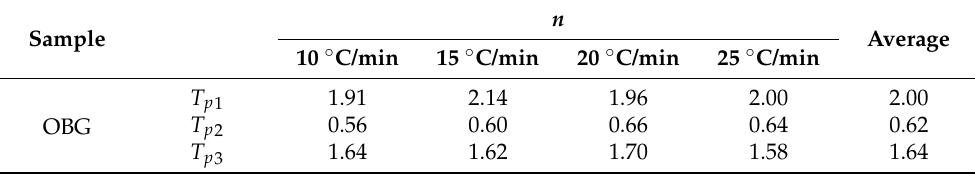
Table 4. Crystal growth index n of the OBG.